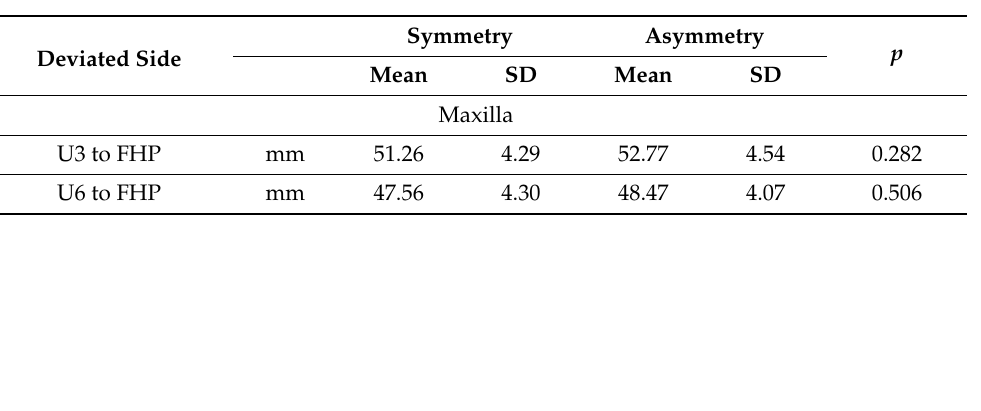
Table 5. Comparison of 3D preoperative (T0) measurements of bilateral variables between groups S and A (deviated